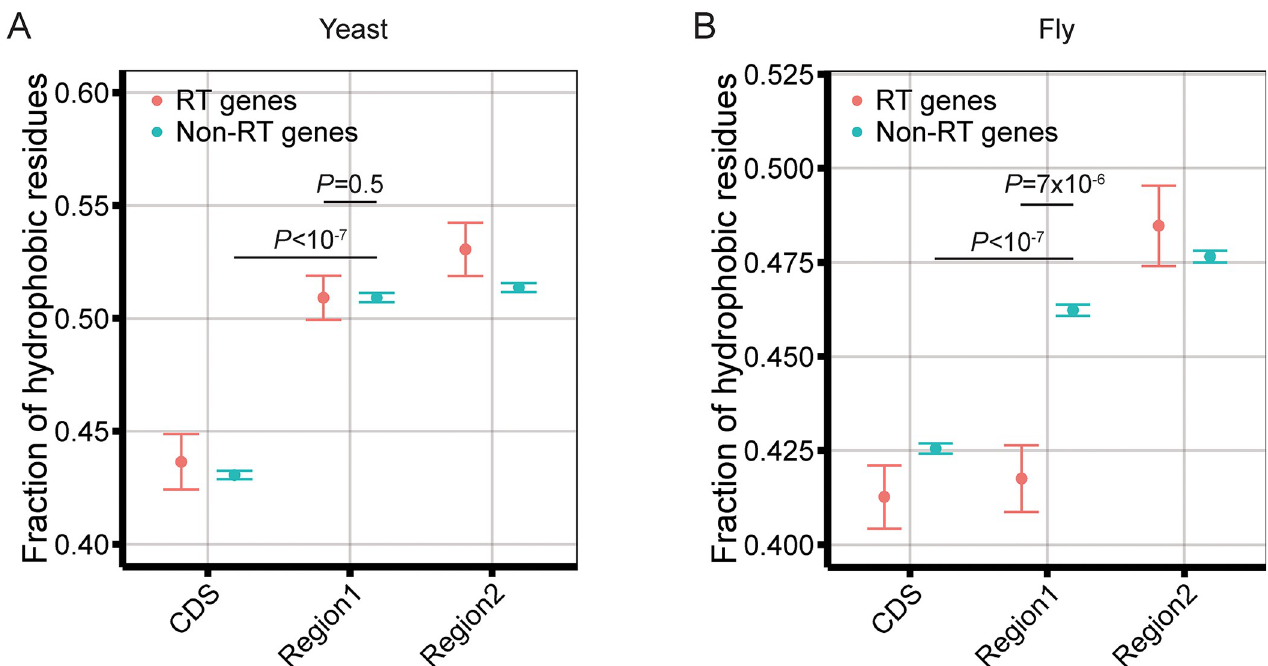
Fig 4. Read-through (RT) regions have reduced amino acid hydrophobicity compared with non-read-through (non-RT) regions. Presented are the fractions of hydrophobic amino acids in the peptides conceptually translated from the last 16 codons of the coding region (CDS), region 1, and region 2 in 172 read-through genes and 6,399 non-read-through genes of the yeast ( A ) or 294 read-through genes and 11,389 non-read-through genes in the fruit fly ( B ). Error bars show standard errors determined by bootstrapping genes. One-tailed P -value is based on respectively bootstrapping genes of the two groups being